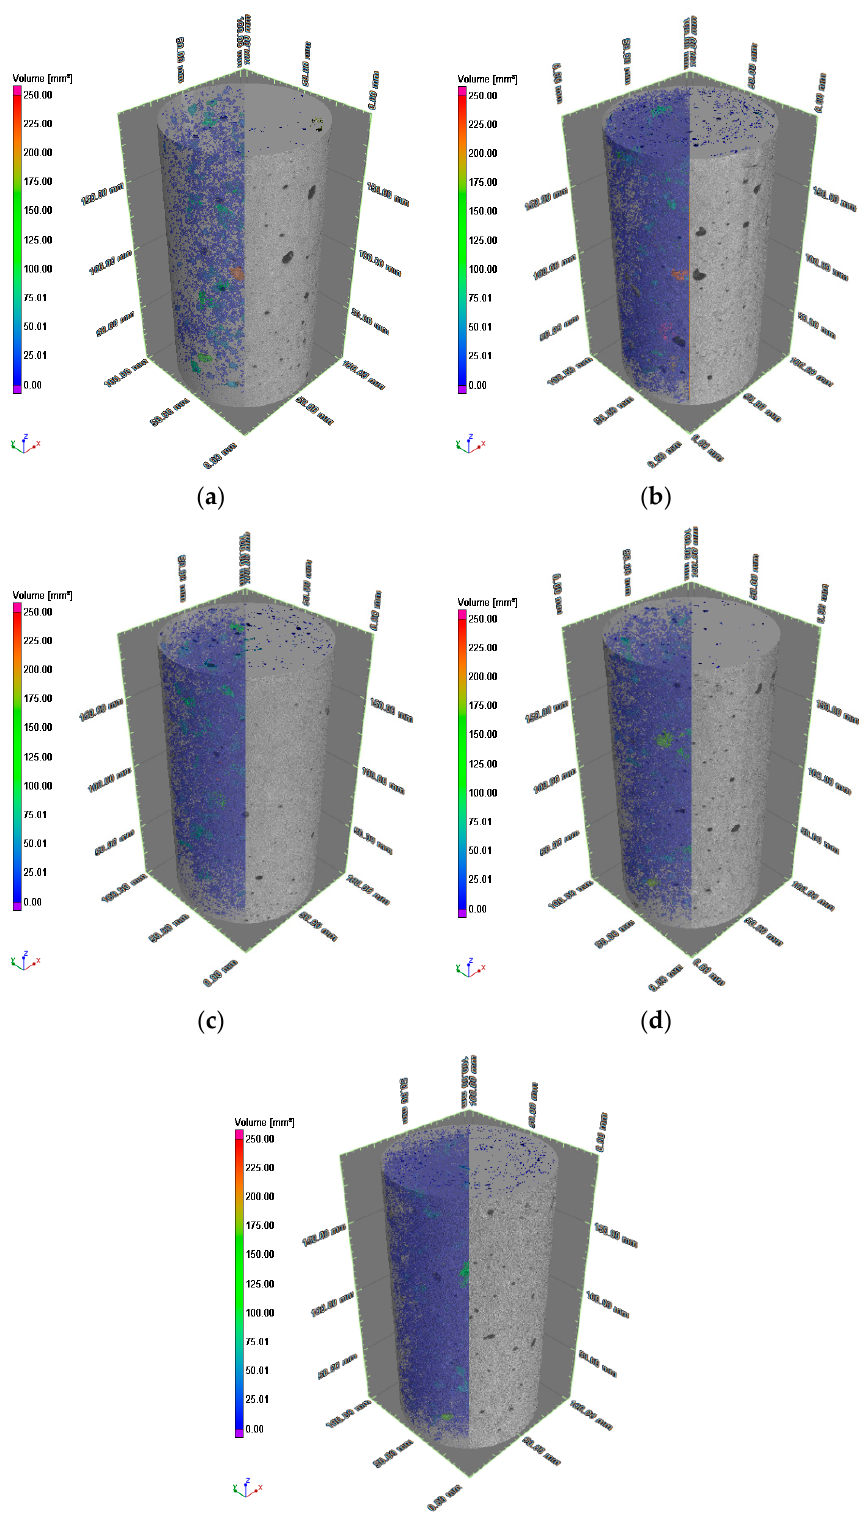
Figure 19. Three-dimensional reconstruction and porosity analysis images: ( a ) NC natural aggregates concrete; ( b )FRC01 no fiber; (c) FRC05 with 0.08% fibers; ( d ) FRC06 with 0.12% fibers; ( e ) FRC07 with 0.16% fibers.